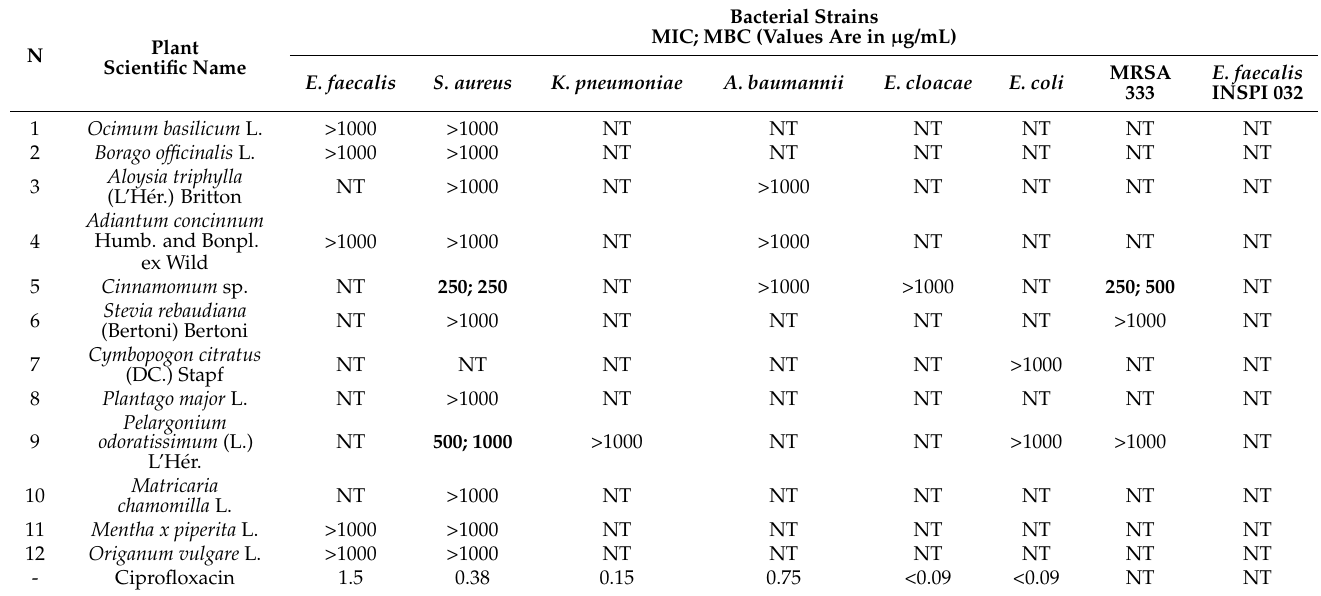
Table 4. Minimum inhibitory concentrations (MICs) and minimal bactericidal concentrations (MBCs) of crude plant extracts used in the herbal infusion horchata against bacterial strains of clinical